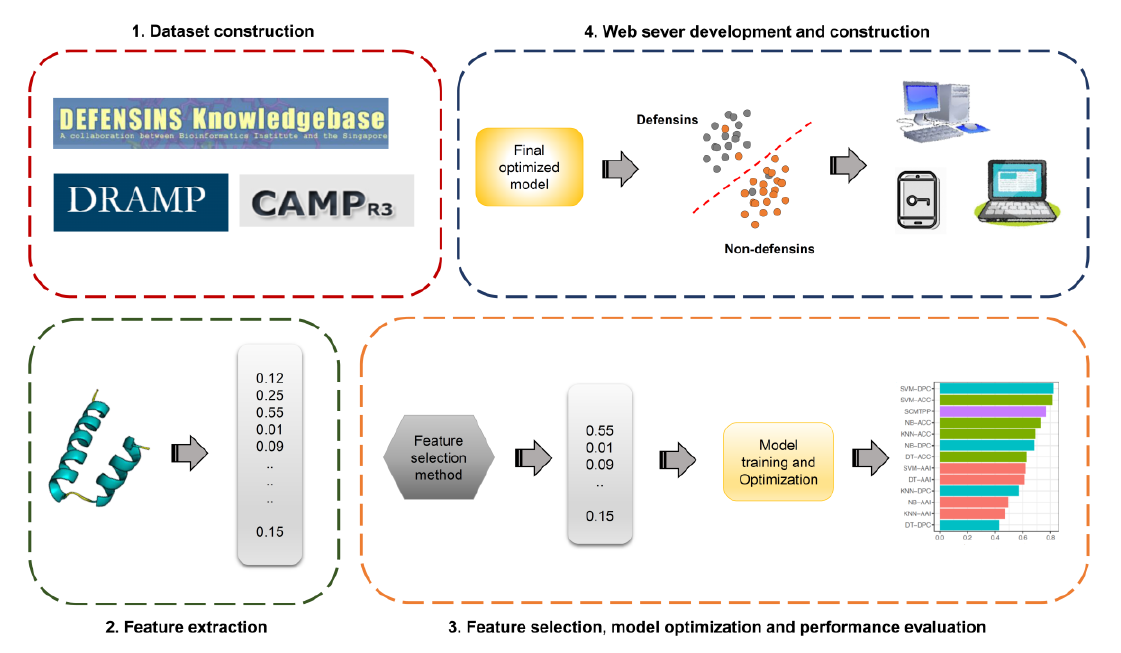
Figure 1: The general machine learning framework of the prediction of defensins and their family/sub- family